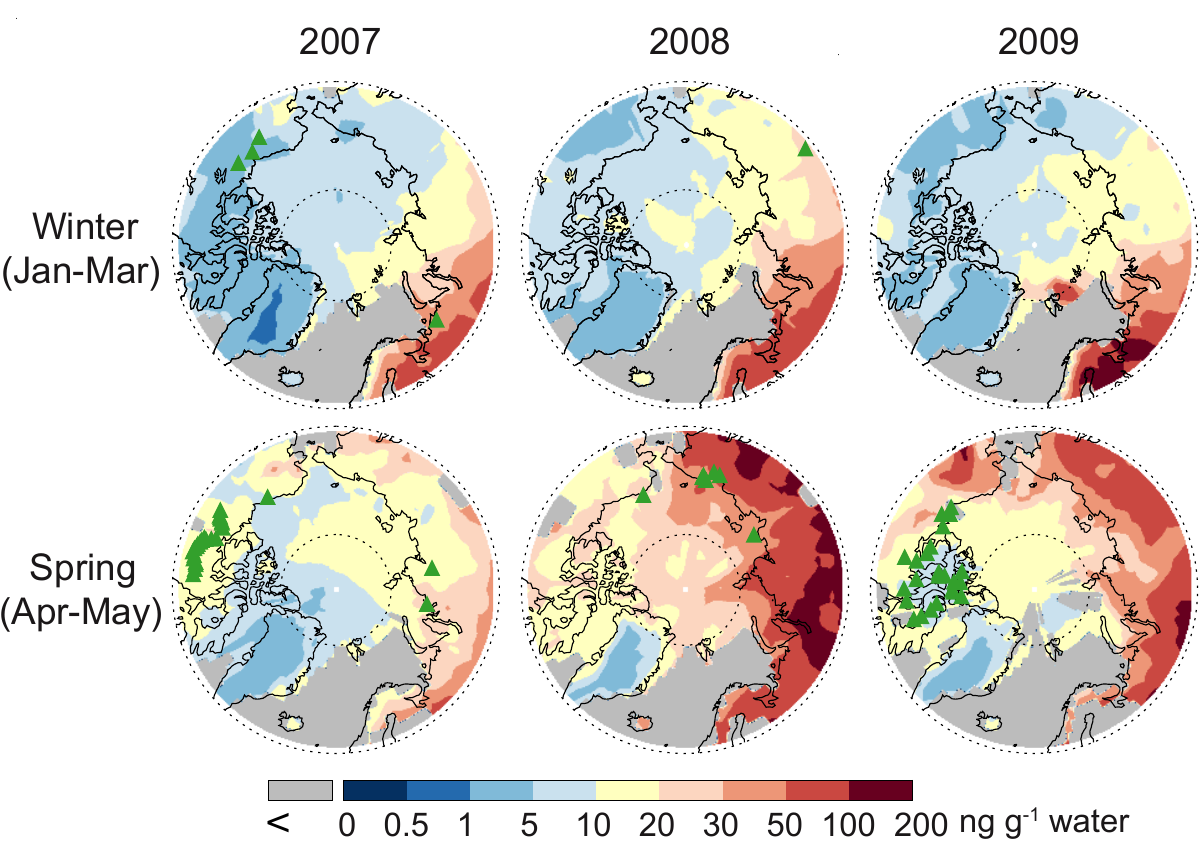
Fig. 12. Simulated BC content of Arctic snow in winter and spring 2007–2009. Snow-free areas are shown in gray. Green triangles indicate snow sampling sites from Doherty et al. (2010) for the corresponding years and seasons.